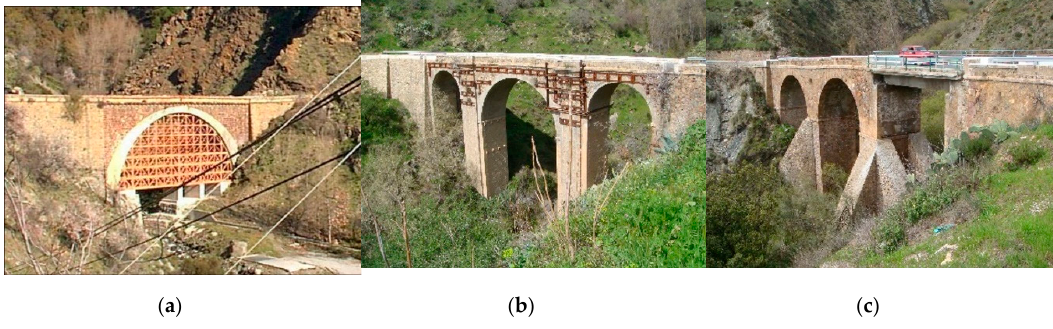
Figure 1. Examples of bridges, near Ízbor bridge, which present certain pathologies. ( a ) A bridge over the Bayacas river in Órgiva. ( b ) A bridge over the Válor river. ( c ) A bridge over the Viñas river.